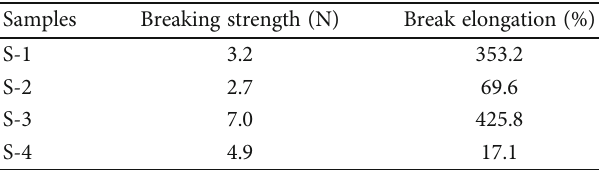
Table 4: Mechanical properties of WPU composite membrane. Samples